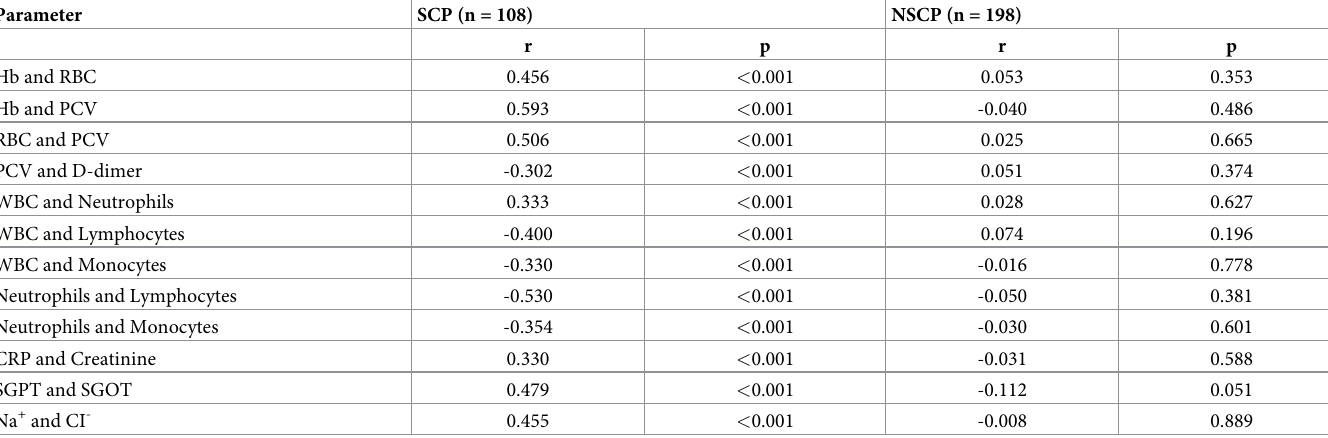
Table 3. Correlations among research parameters in the cohort at different severity stages of COVID-19.